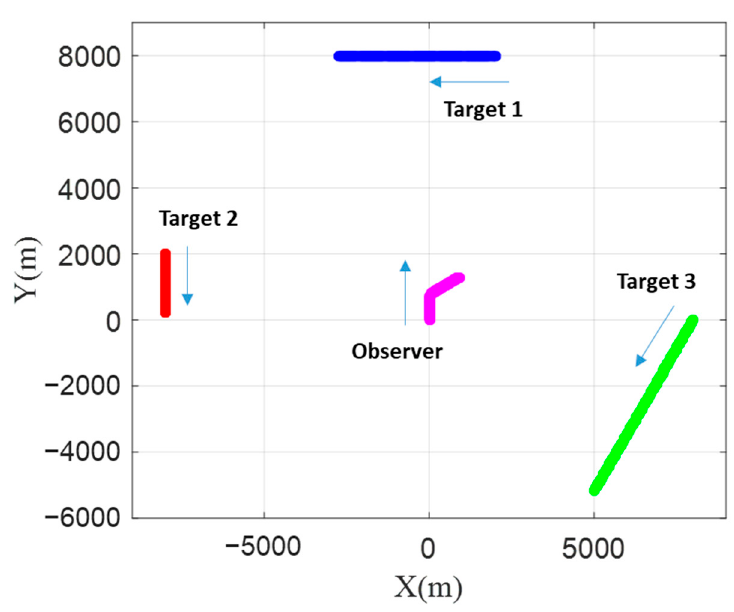
Figure 1. Trajectories of Target 1, Target 2, Target 3, and the observer in the horizontal plane. Table 1. Observer and target information. Table 1. Observer and target